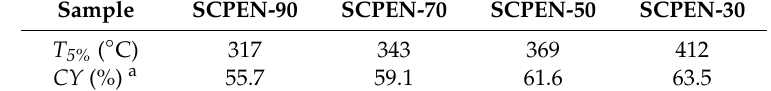
Figure 4. ( a ) The photo and ( b ) cross-sectional SEM images of SCPEN films. 3.4. IEC, Water Uptake and Swelling Ratio of SCPEN Films IEC reflects the density of H + exchangeable functional groups in the film, which is determined by a typical acid-base titration method. The IEC values are related to the content of the sulfonic acid group, as shown in Table 3. In order to check the dimensional stability of the polymer, the water